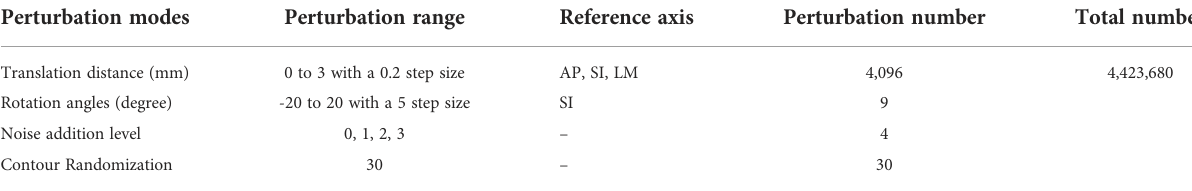
TABLE 2 The parameters of perturbation